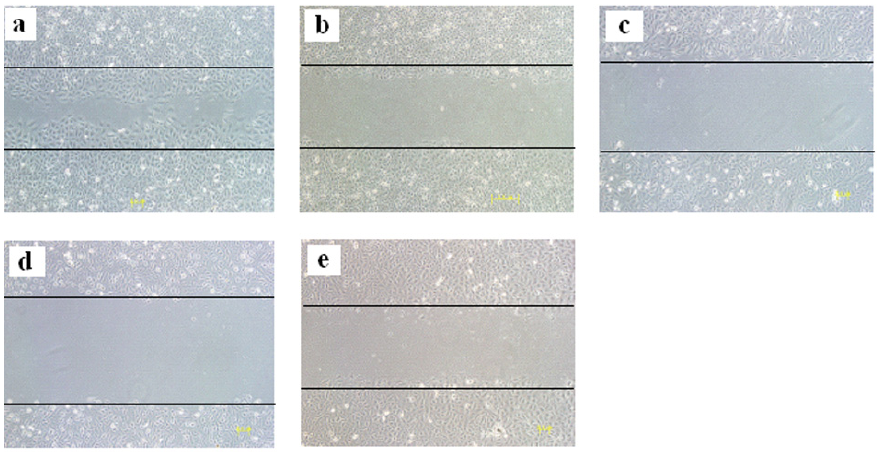
Figure 3. Effects of xanthones on HUVEC migration in wound migration assays. ( a ): Control, medium alone. ( b ) 0.5 μ M xanthone 1 . ( c ) 0.5 μ M xanthone 3 . ( d ) 0.5 μ